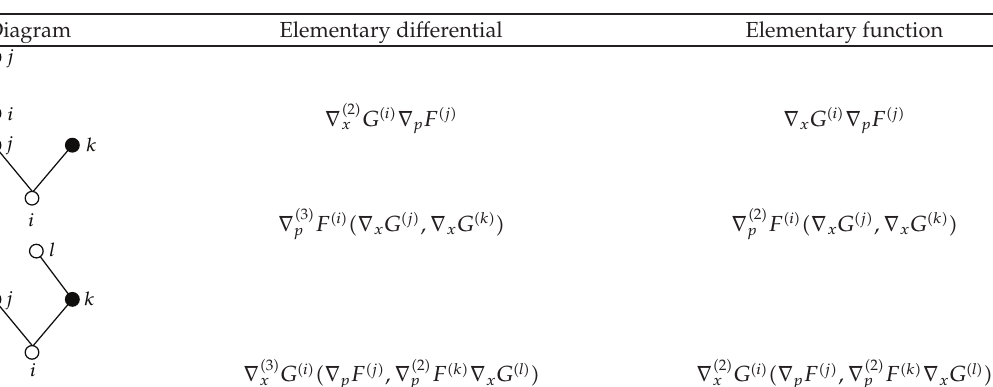
Diagram Elementary di ff erential Elementary function